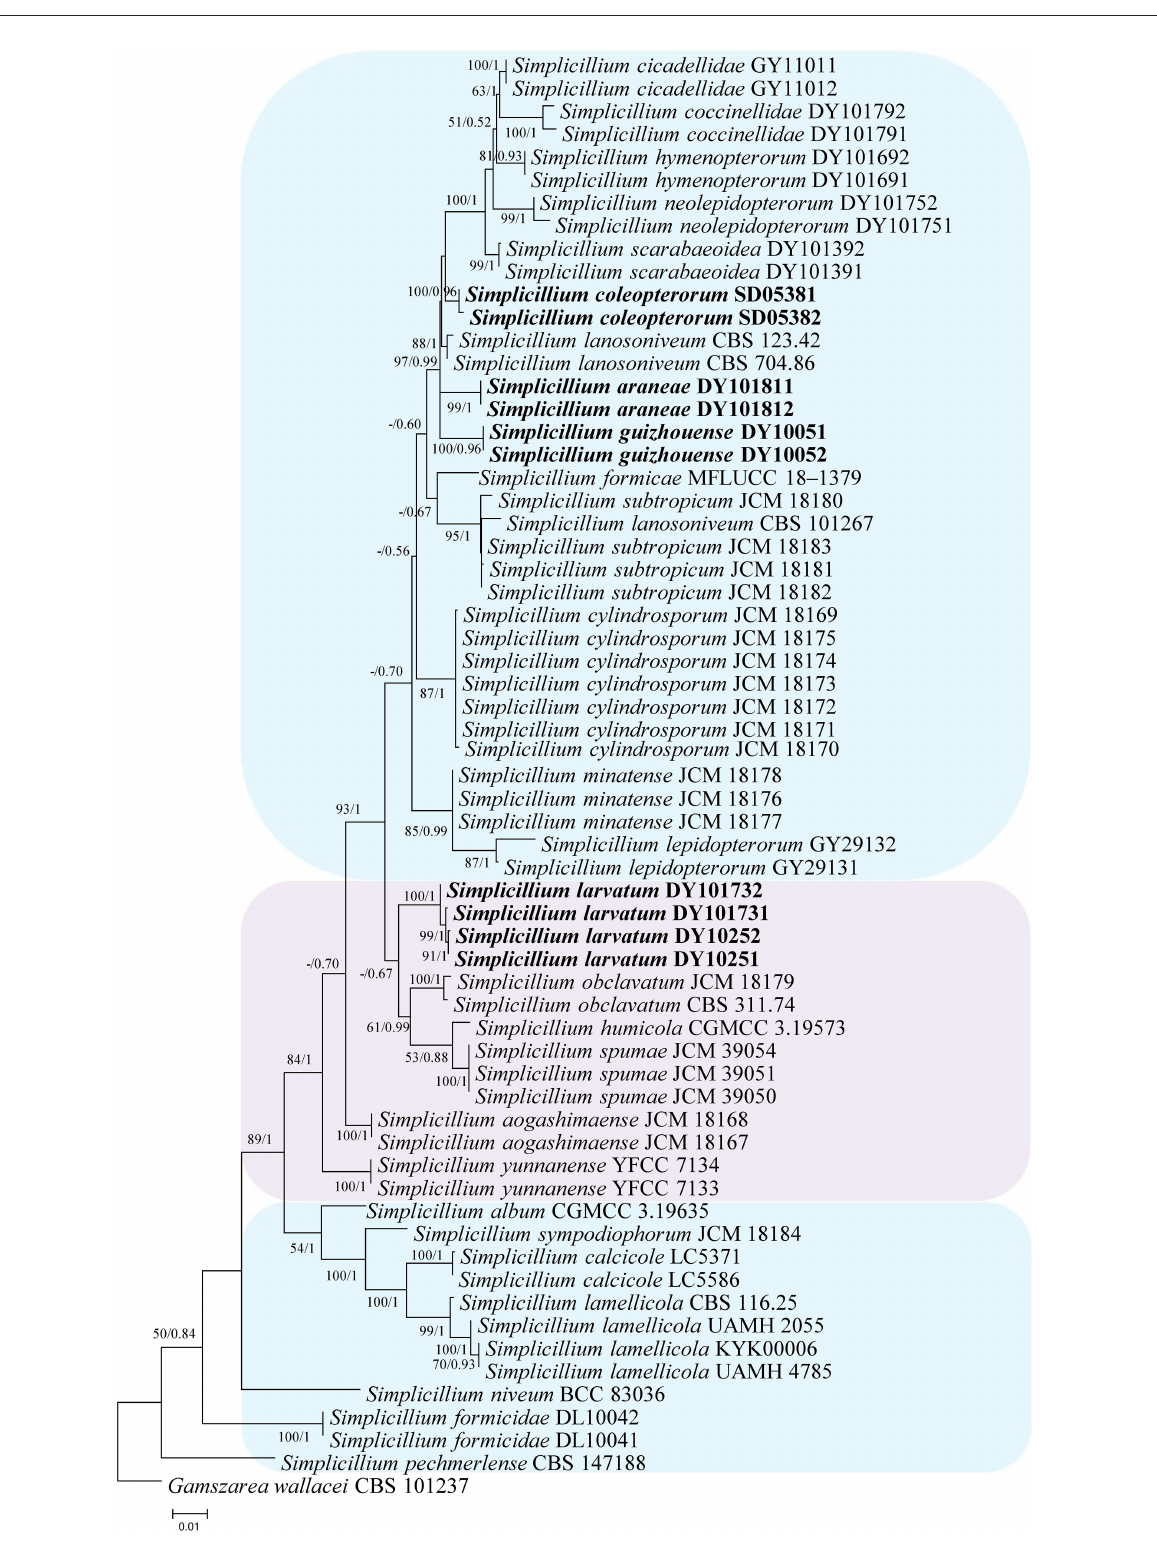
FIGURE2 Phylogenetic analysis to establish the new species in the genus Simplicillium by SSU, ITS, LSU, RPB1, and TEF sequences. Statistical support values ( ≥ 0.5/50%) are shown at the nodes for ML bootstrap support/BI posterior